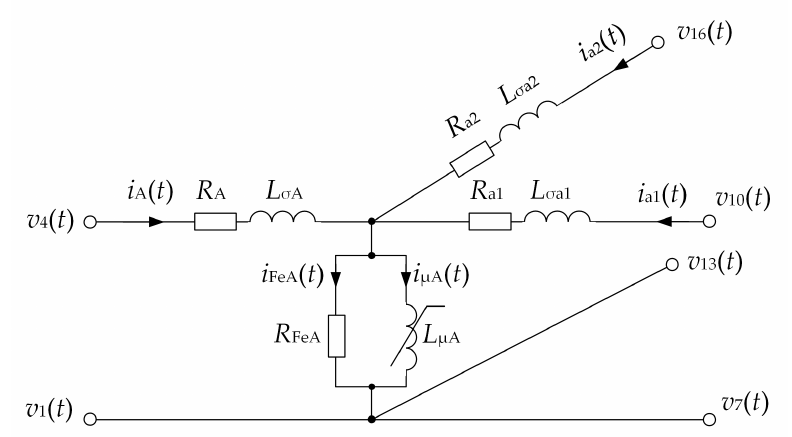
Figure 15. Schematic diagram for one phase of the